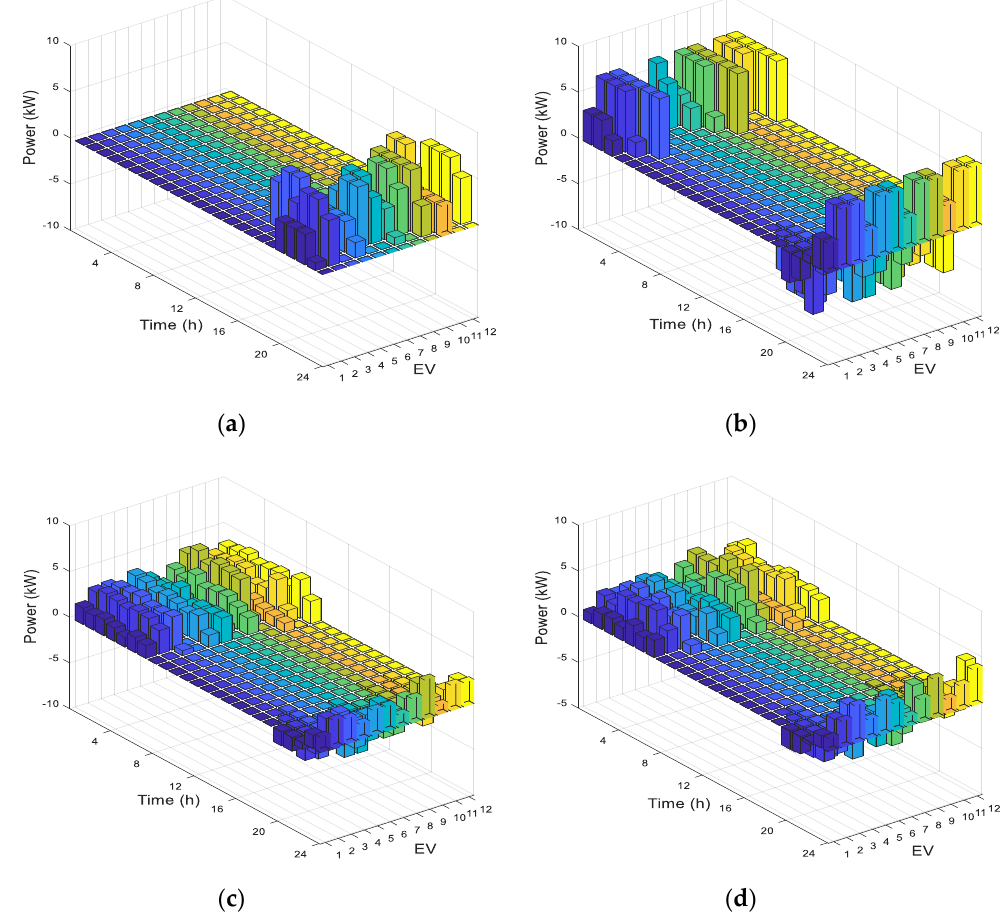
Figure 6. EVs charging scheduling; dump charging ( a ). time of use (TOU) charging ( b ). optimal Figure6. EVschargingscheduling; dumpcharging( a ). timeofuse(TOU)charging( b ). optimalcharging charging in summer ( c ) and in winter ( d ). in summer ( c ) and in winter ( d